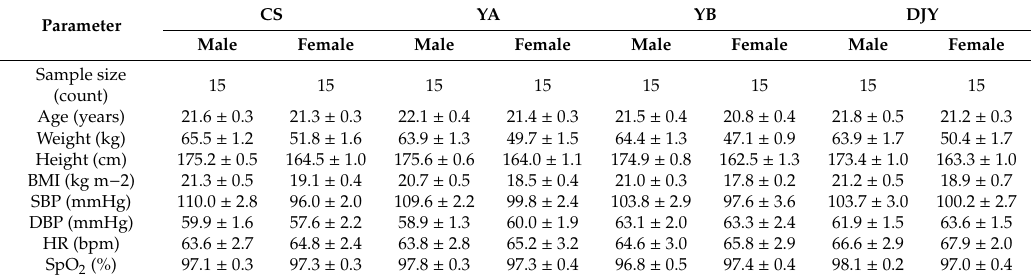
Body mass index (BMI) = weight (kg) / [height (m) 2 ]. All data are presented as the mean ± SEs ( n = 15 per group). CS: city site; YA: Ya’an site; YB: Yibin site; DJY: Dujiangyan site. DBP: diastolic blood pressure; SBP: systolic blood pressure; SpO 2 : blood oxygen saturation